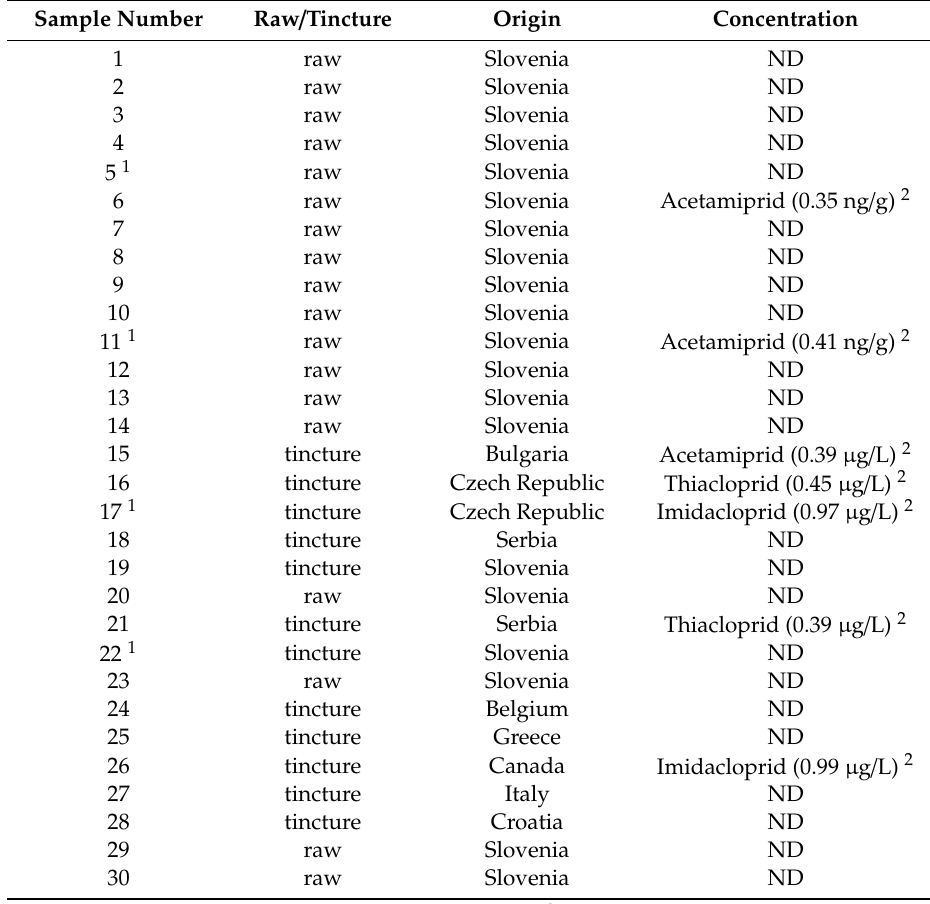
Table 3. Characteristics of analysed propolis samples and concentration of